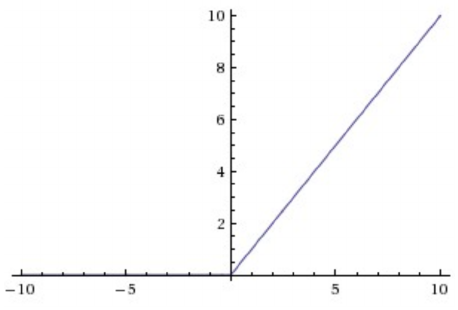
Figure 2. The relu activation function